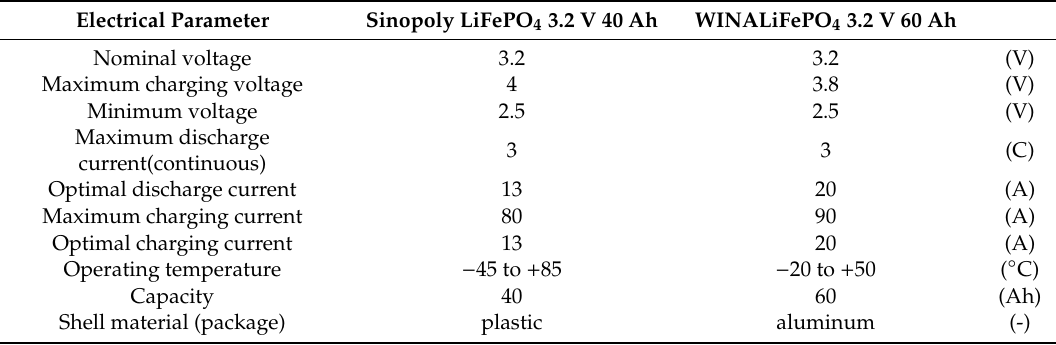
Table 1. Technical parameters of investigated cell Sinopoly LiFePO 4 3.2 V 40 Ah.